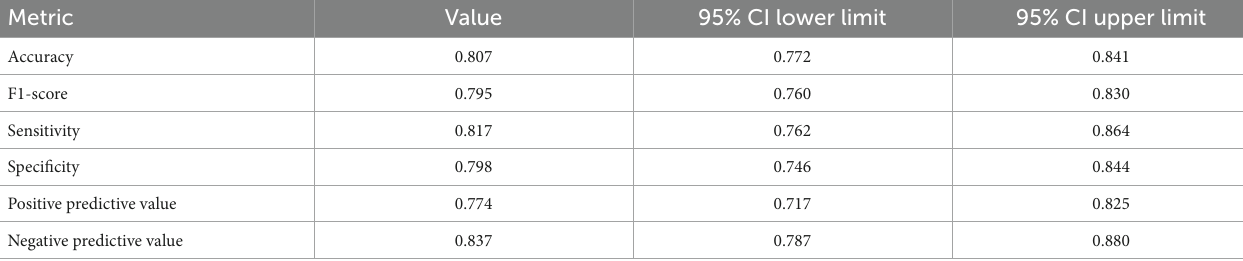
TABLE 7 Results of performance metrics for Lojistic regression model maturity prediction.